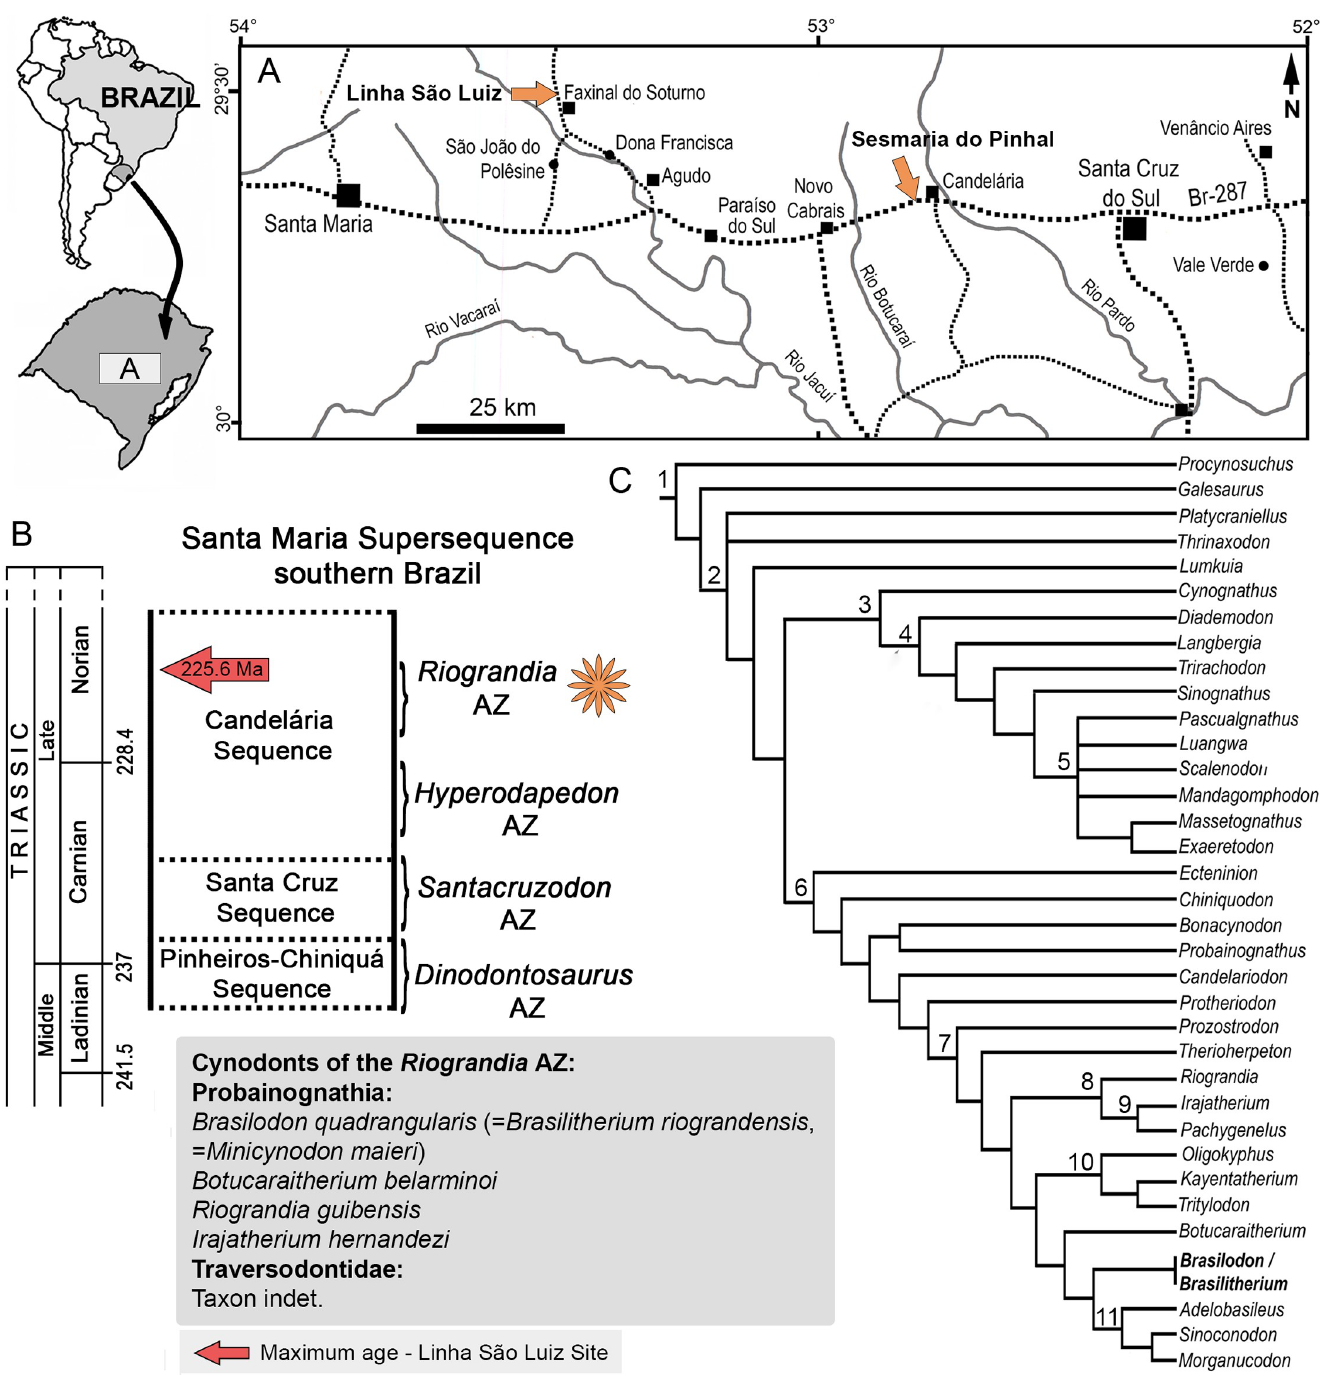
Fig 1. Localities and stratigraphic level with Brasilodon quadrangularis . A , location map showing the Linha S ã o Luis and Sesmaria do Pinhal sites, in Rio Grande do Sul state, southern Brazil; B , chrono- and biostratigraphy of Triassic units with vertebrate assemblage zones (AZ); C , compositive phylogenetic position of Brasilodon amongst Probainognathia (based on [6–7, 25]). Clade names: 1, Cynodontia; 2, Epicynodontia; 3, Cynognathia; 4, Gomphodontia; 5, Traversodontidae; 6, Probainognathia; 7, Prozostrodontia; 8, Ictidosauria; 9, Tritheledontidae; 10, Tritylodontidae: 11, Mammaliaformes. The ages (Ma) of the column follow Ogg et al. [78], chrono- and biostratigraphy were modified from Zerfass et al. [75] and Horn et al. [76], the age of Riograndia AZ was taken from Langer et al. [77].